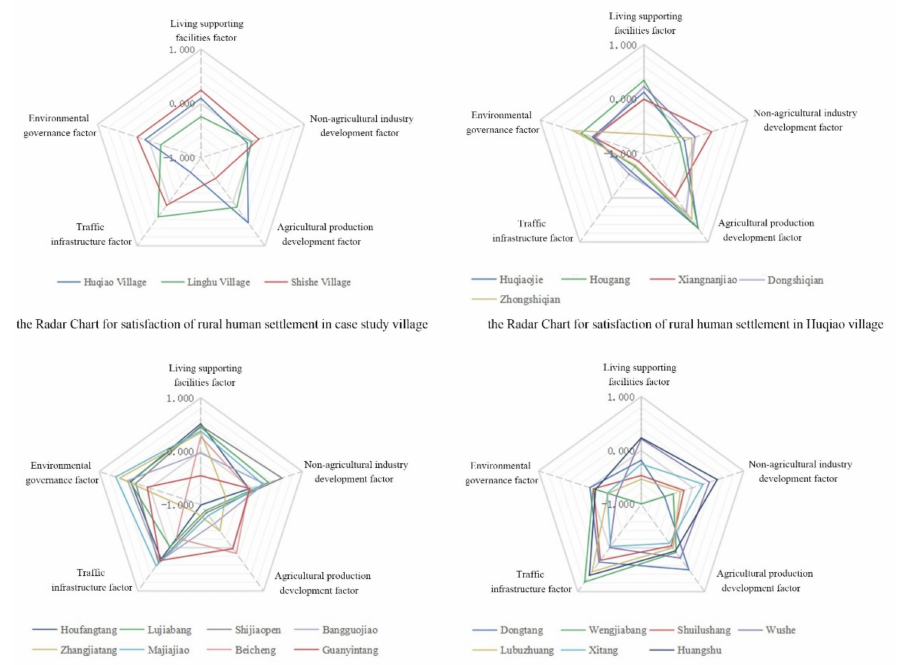
Figure 3. Radar chart for satisfaction of rural human settlement.